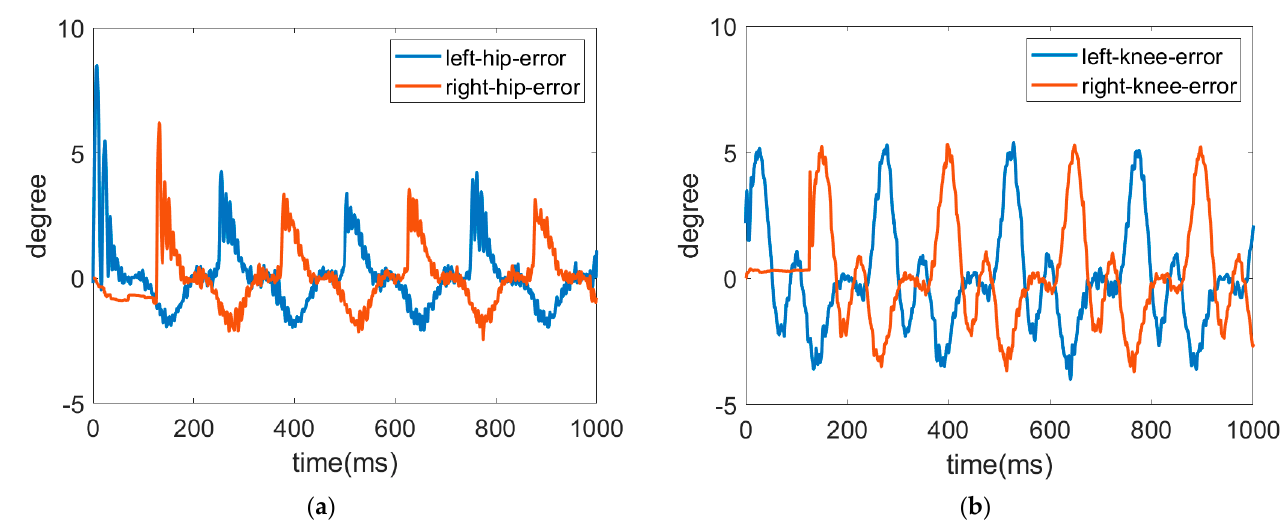
Figure 16. Trajectory errors of hip joint and knee joint while ascending. ( a ) Tracking error of hip joint. ( b ) Tracking error of knee joint.